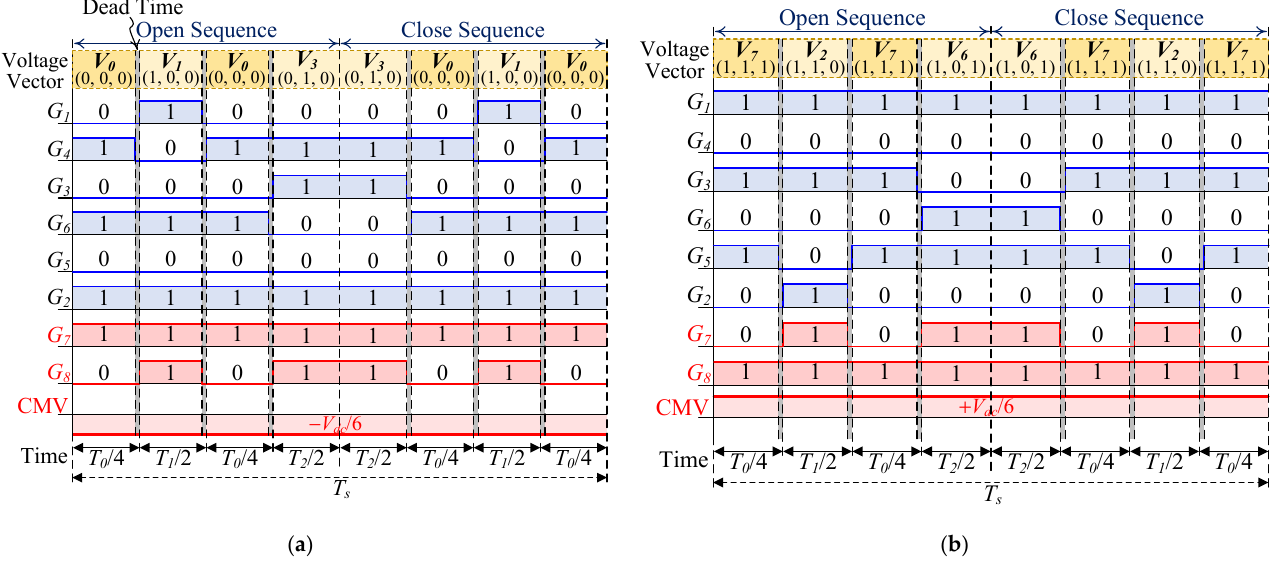
Figure 5. Modulation sequences of proposed method when G 1 – G 8 denote gate signals of switches S 1 – S 8 , respectively: ( a ) Sector 1; ( b ) Sector 2.